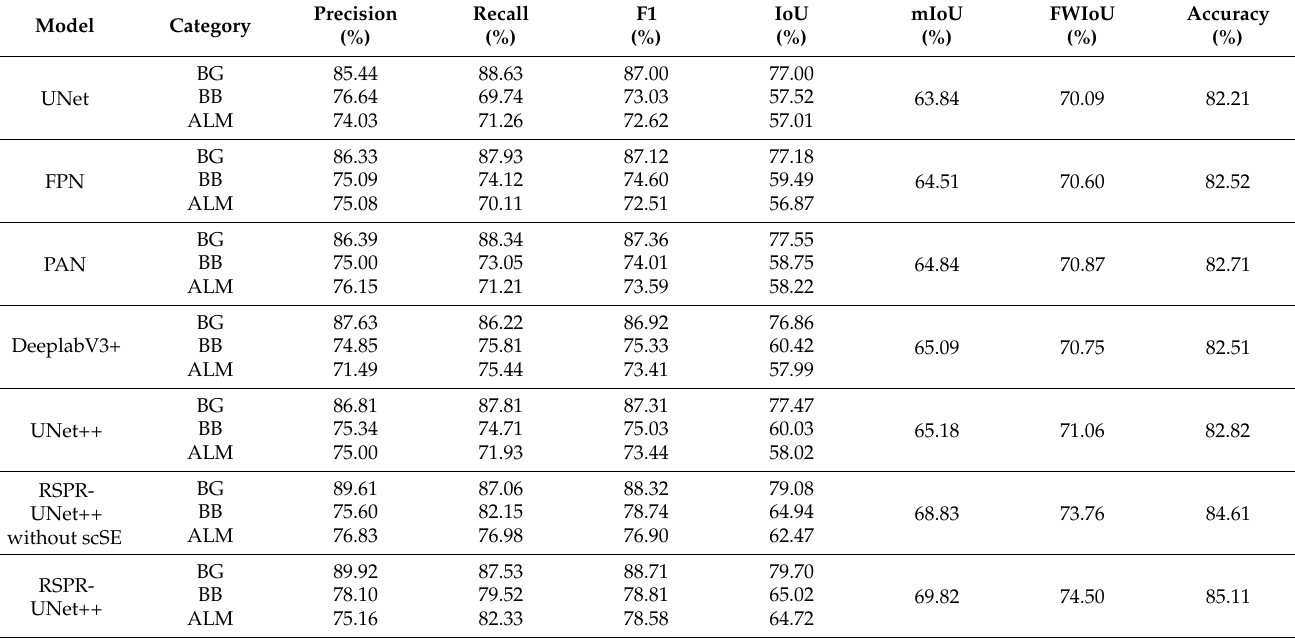
Table 5. The experimental outcomes of RSPR-UNet++ and other methods. BG represents the background, BB the bark beetle, and ALM the aspen leaf